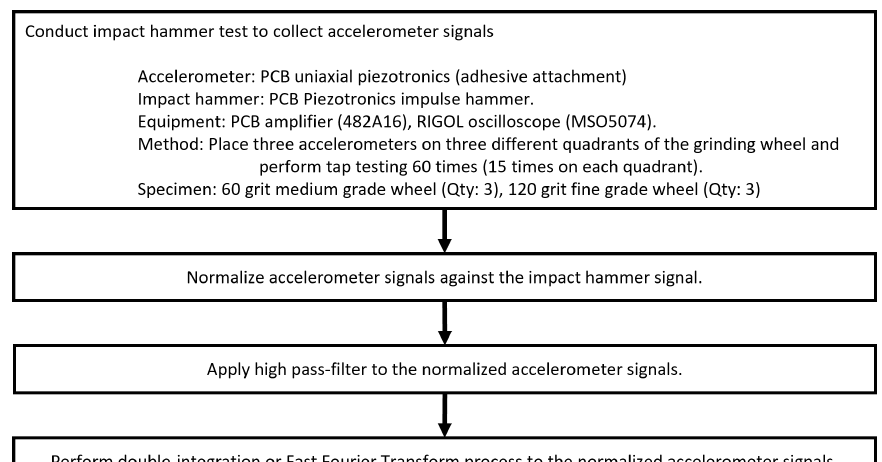
Figure 6. Accelerometer signal processing